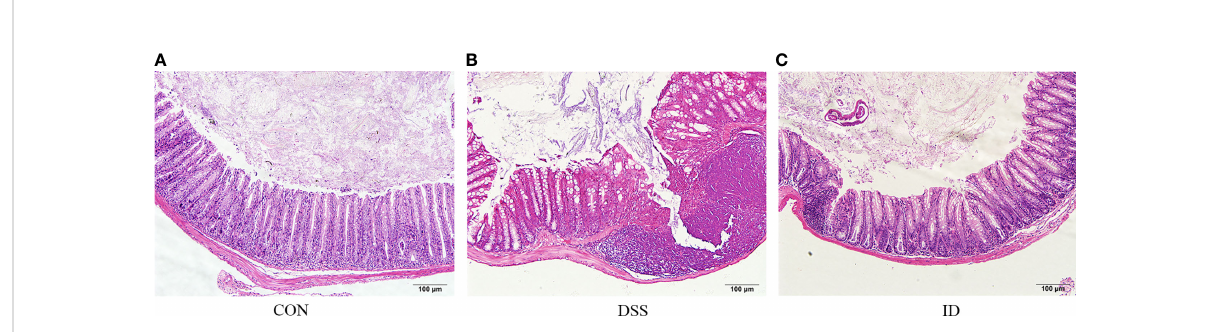
FIGURE 1 IPA alleviates DSS-induced colon epithelial damage. Hematoxylin and eosin-stained sections ofcolonsfromthe CON group (A) , DSS group (B) and ID group (C) (scale bar =